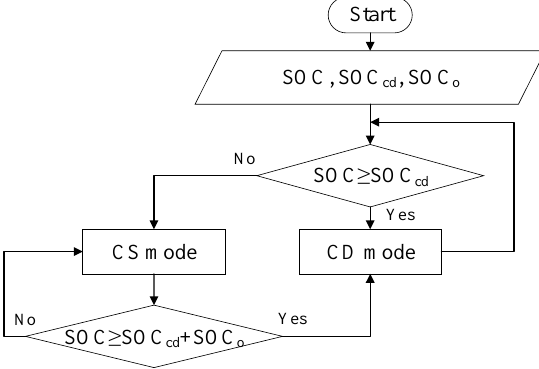
Figure 4. Operating mode switching strategy.